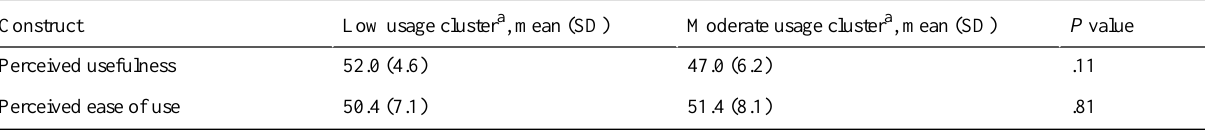
Table 3. t test for equality of means on usability